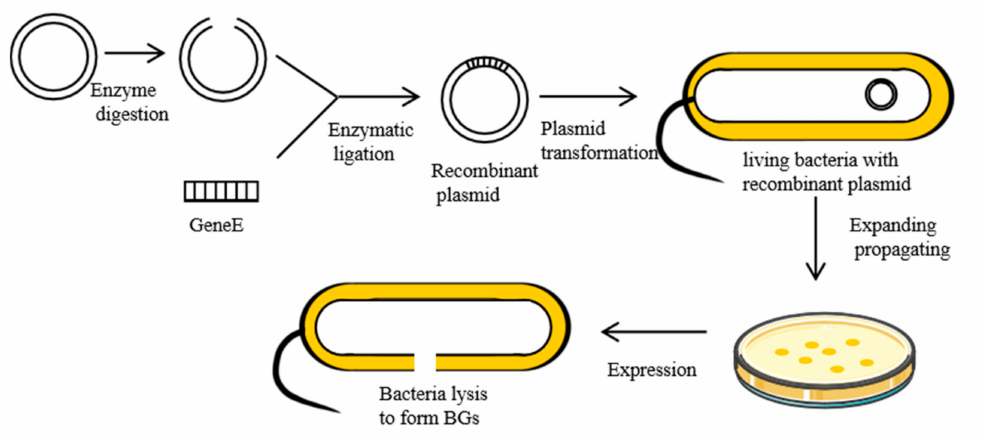
Figure 2. Preparation of the BGs using genetic